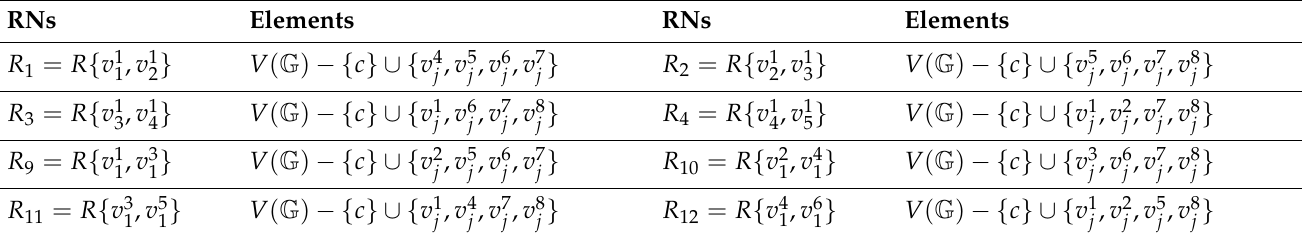
Table 9. RNs R r for 1 ≤ l ≤ 12 and 1 ≤ j ≤ 4.